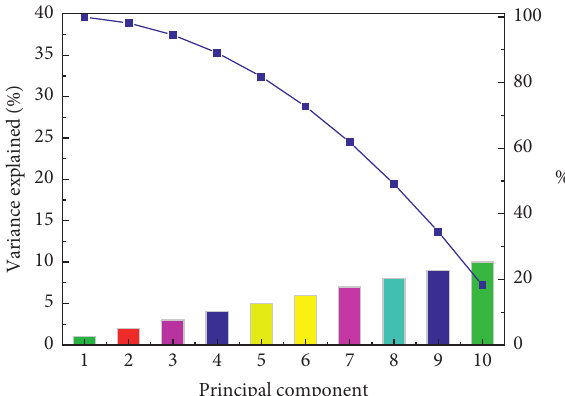
Figure 6: PSMA fusion featured is tributary.